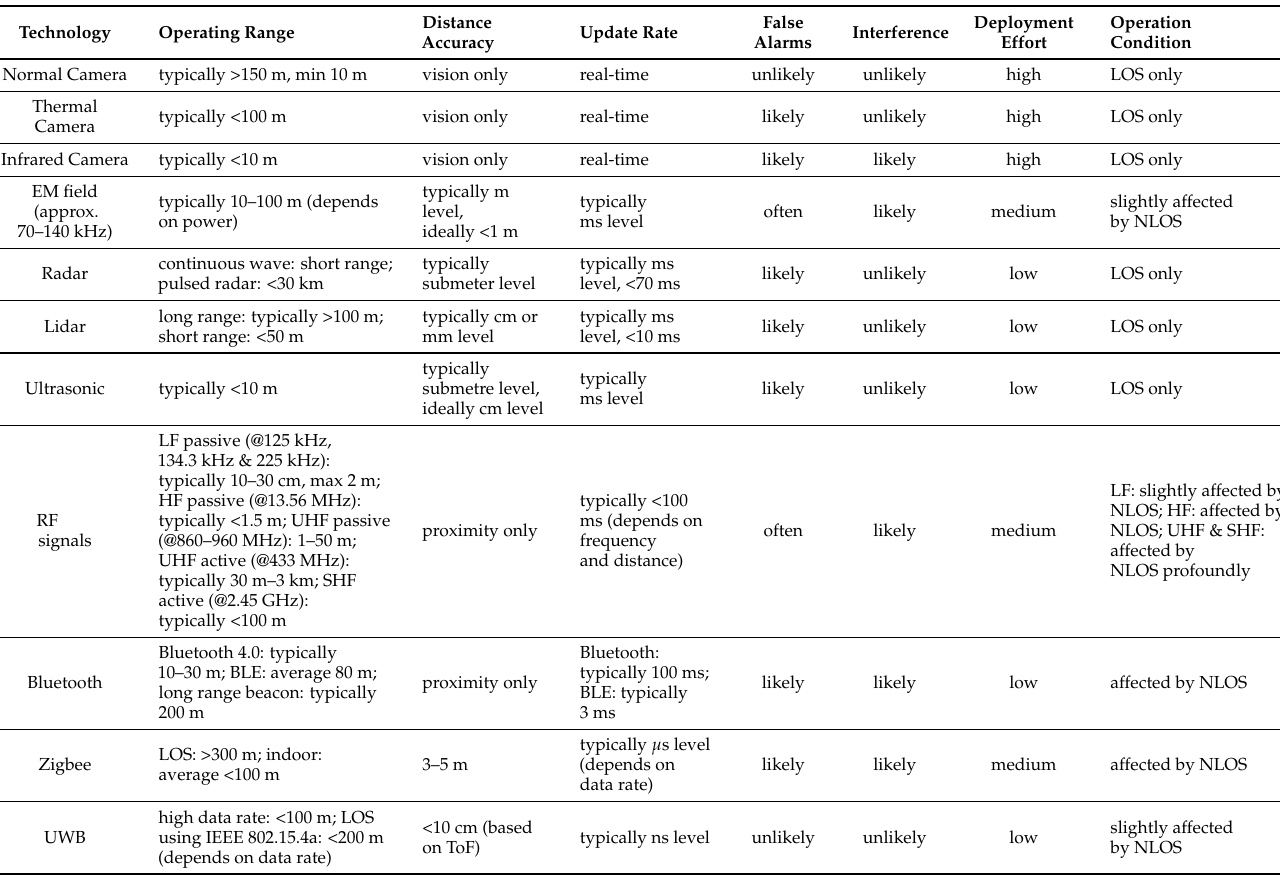
Table 3. Overview and Comparison of Proximity Detection Technologies.